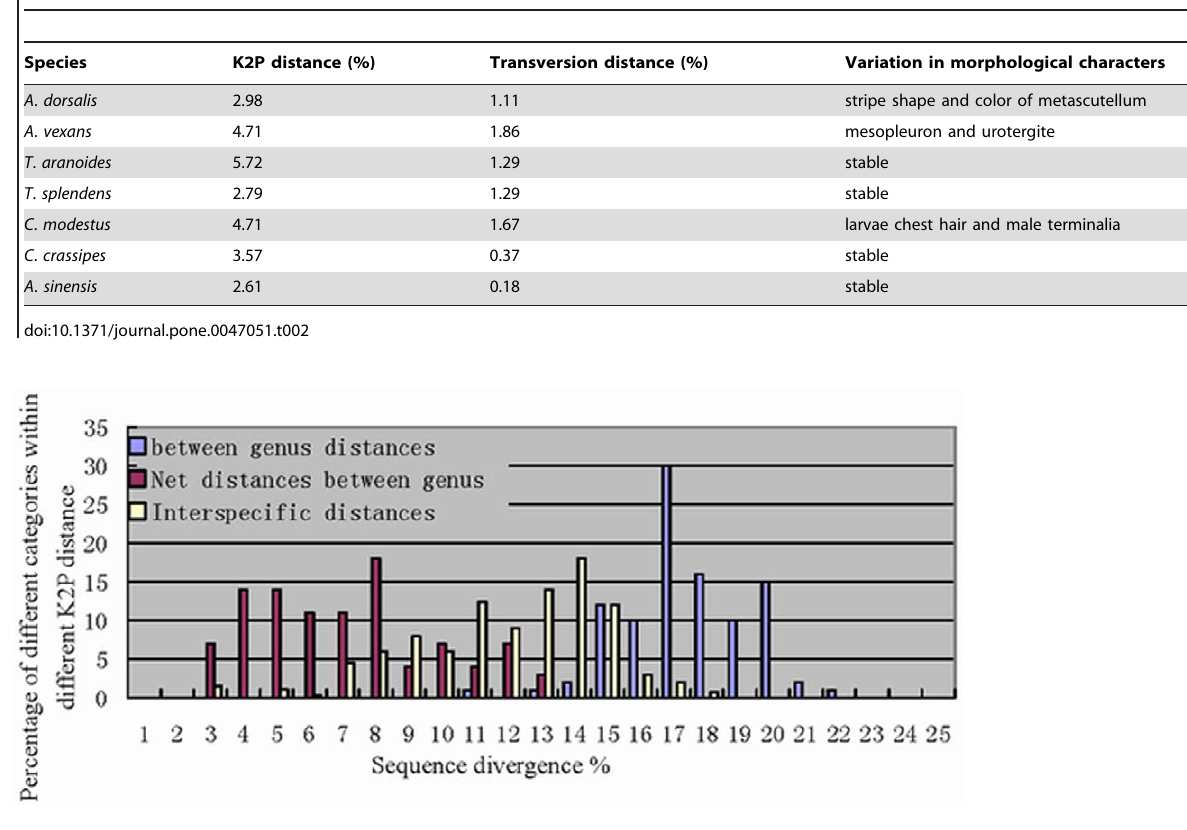
Table 2. Intraspecific K2P distance, transversion distance, and morphological characteristics of some mosquitoes.